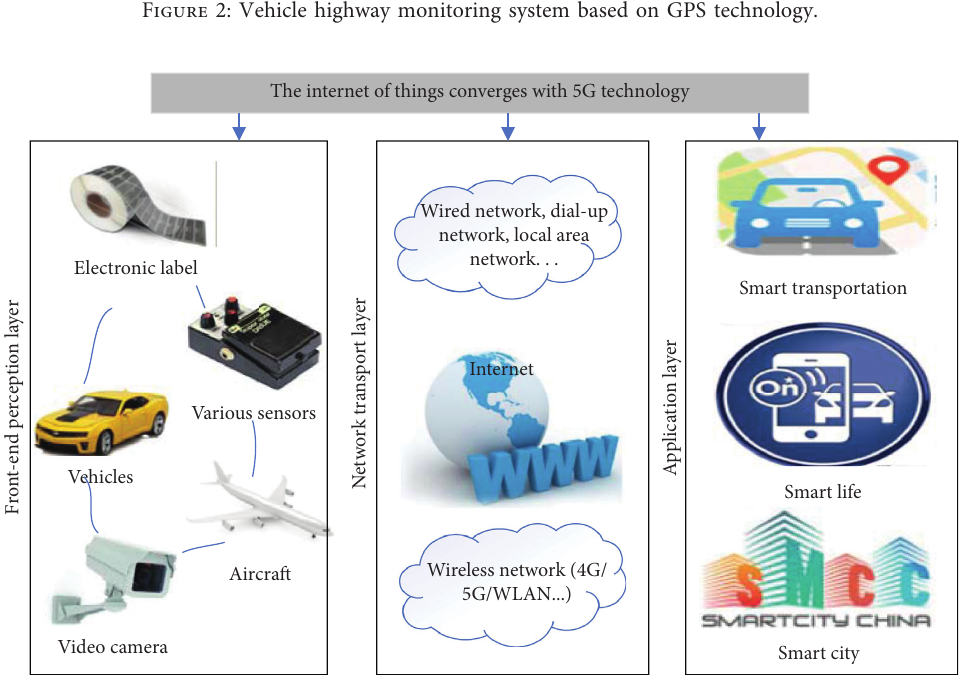
Figure 3: Architecture diagram of IoT fusion 5G technology.